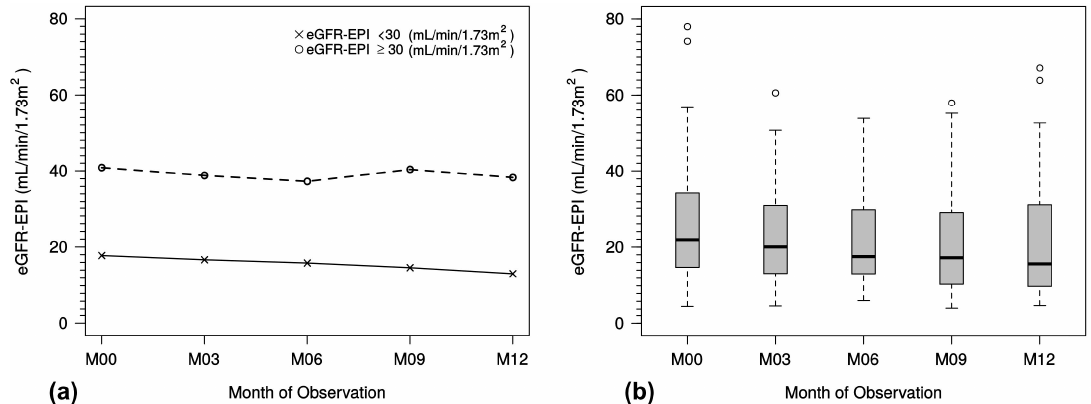
Figure 2. ( a ) Course of eGFR (CKD-EPI) month 0 to month 12 in the predialysis population, stratified by eGFR ≥ 30 and eGFR < 30 mL/min/1.73 m 2 ; ( b ) course of eGFR (CKD-EPI) in the predialysis population. Box-whisker-plot shows median and interquartile range with outliers (open circles). eGFR, estimated glomerular filtration rate; M, month.